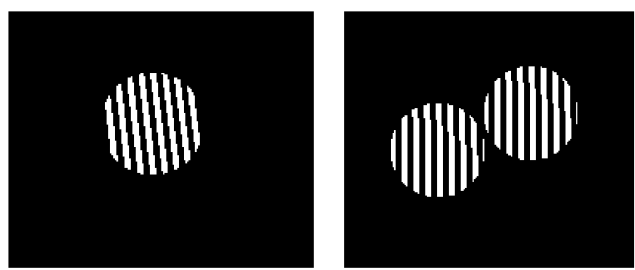
Fig. 3. On the left, small round grating displayed on the DMD to modulate the amplitude of diffracted orders, by changing its rotation, period and width. The round diameter is 32 pixels (438 µ m). On the right, two round gratings displayed on the DMD to modulate diffracted wave by changing their relative phase.